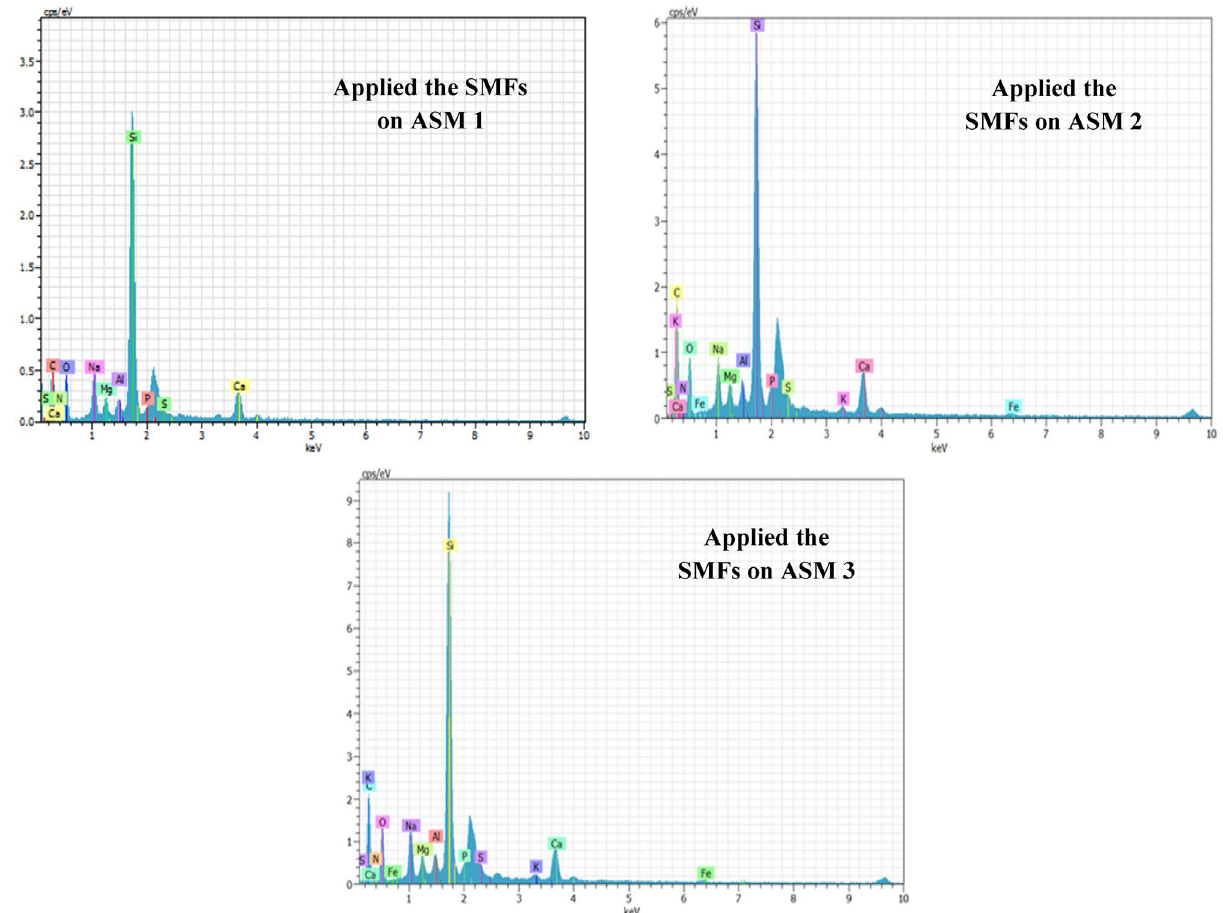
Figure 8. EDS analyses of dried